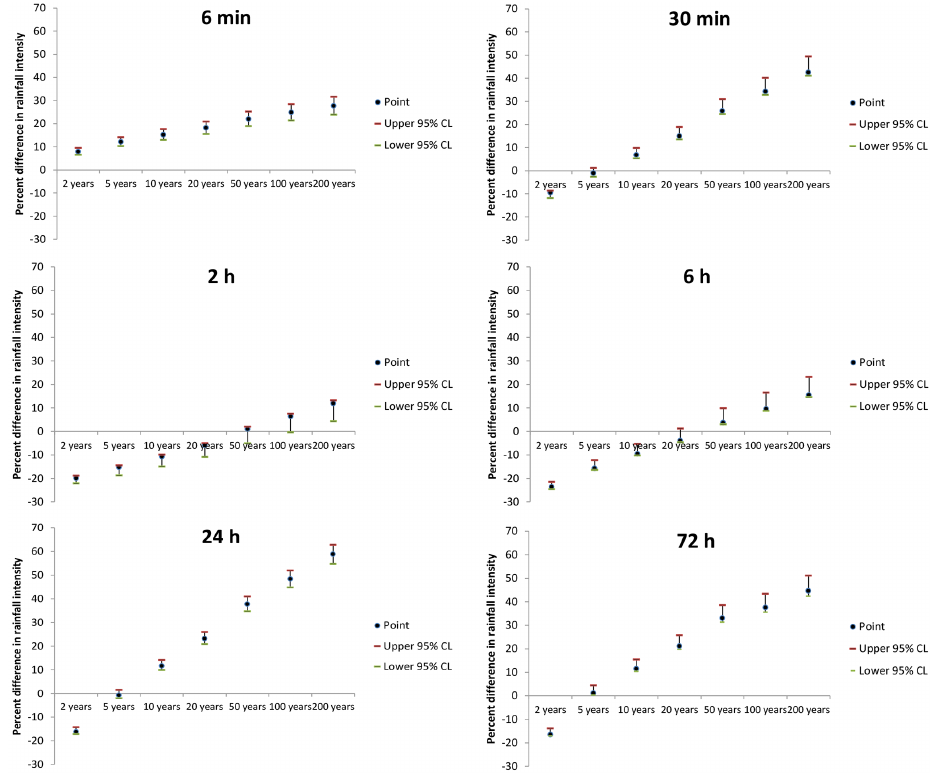
Figure 7. Difference in rainfall intensity for each duration and ARI (for Sydney). Positive (negative) values represent an increase (decrease) in rainfall intensity during positive IPO compared to negative